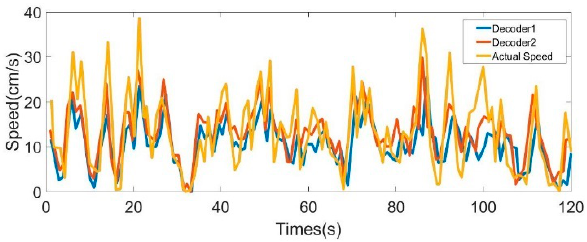
Figure 3. Actual speed and the results of linear decoders.